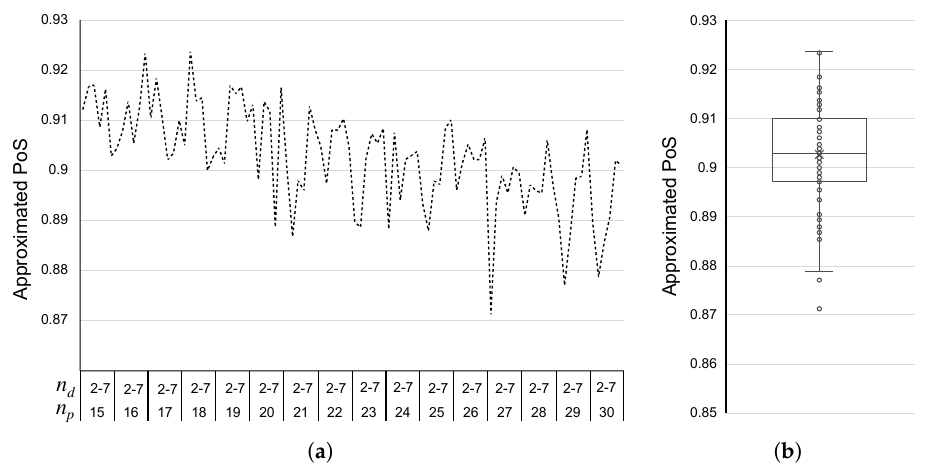
Figure 6. The approximated PoS of the solutions of the proposed algorithm. ( a ) PoS behavior in the increment of the number of passengers and drivers. ( b ) boxplot considering all the combinations.